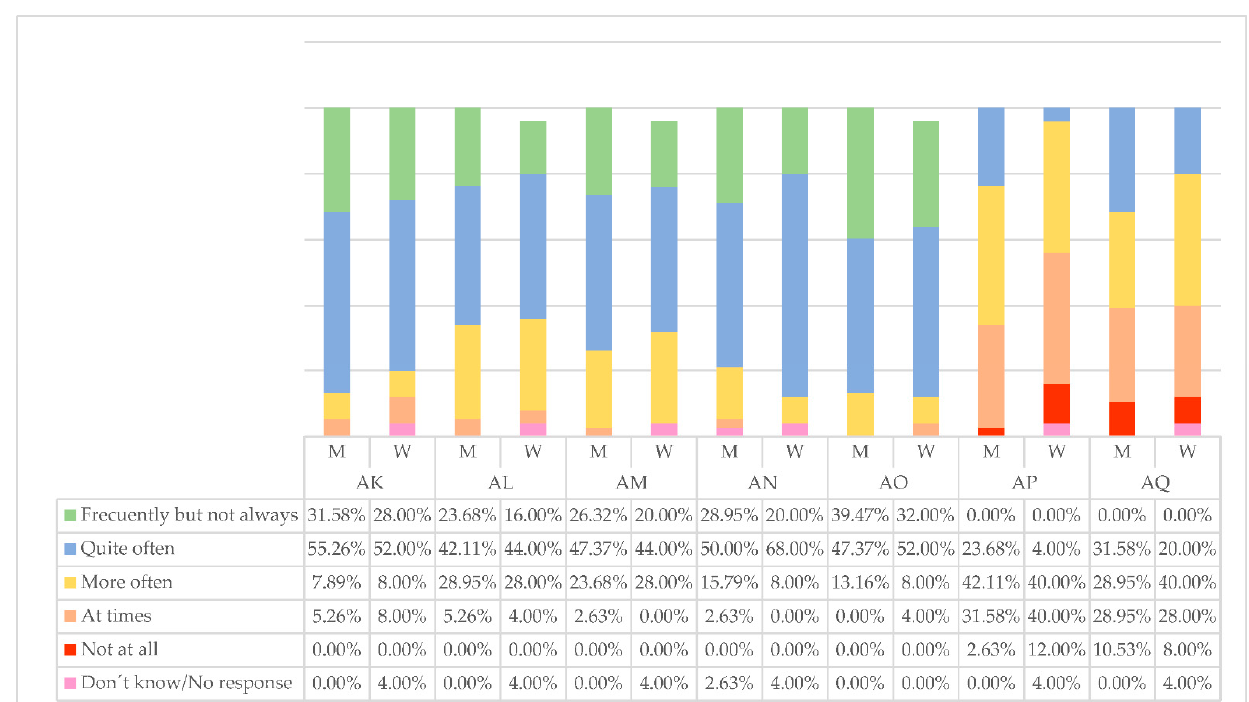
Figure 6. Qualities developed by managers. Source: own elaboration.